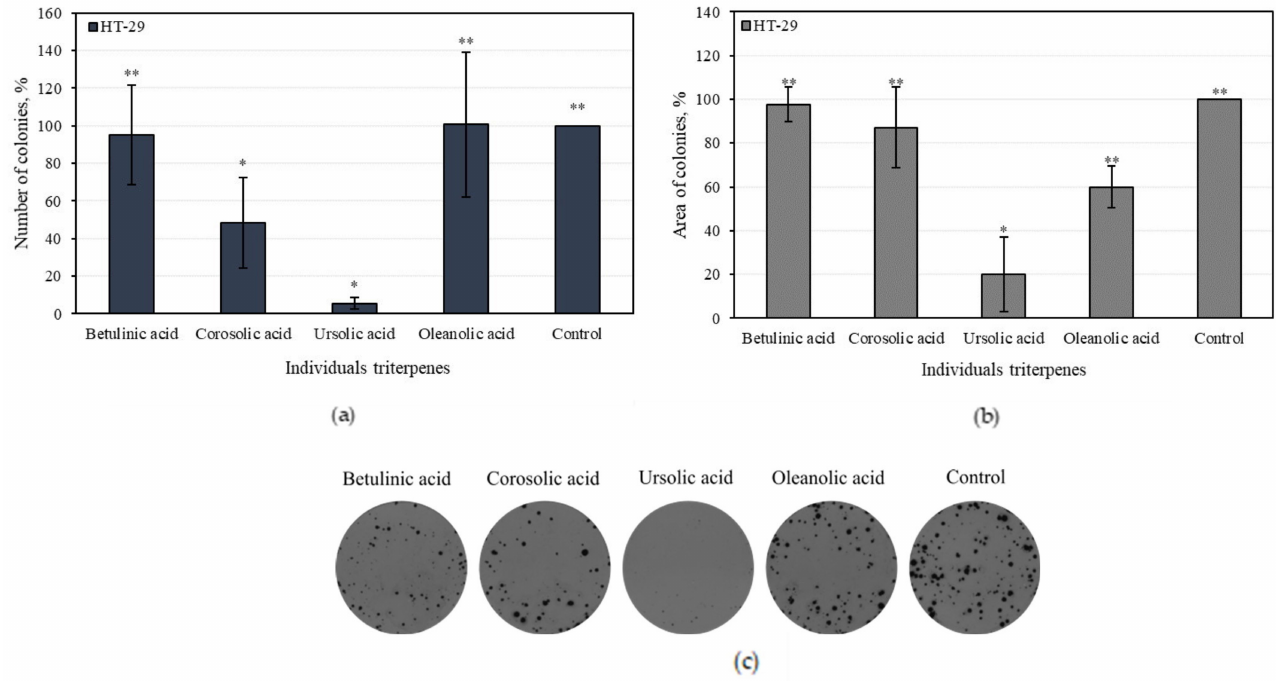
Figure 10. The effect of individual triterpenes on HT-29 colony-forming: ( a ) numbers of colonies; ( b ) area of colonies; ( c ) colonies incubated with different triterpenes. Different signs (*) indicate statistically significant differences at p > 0.05, according to Tukey’s multiple comparison test.